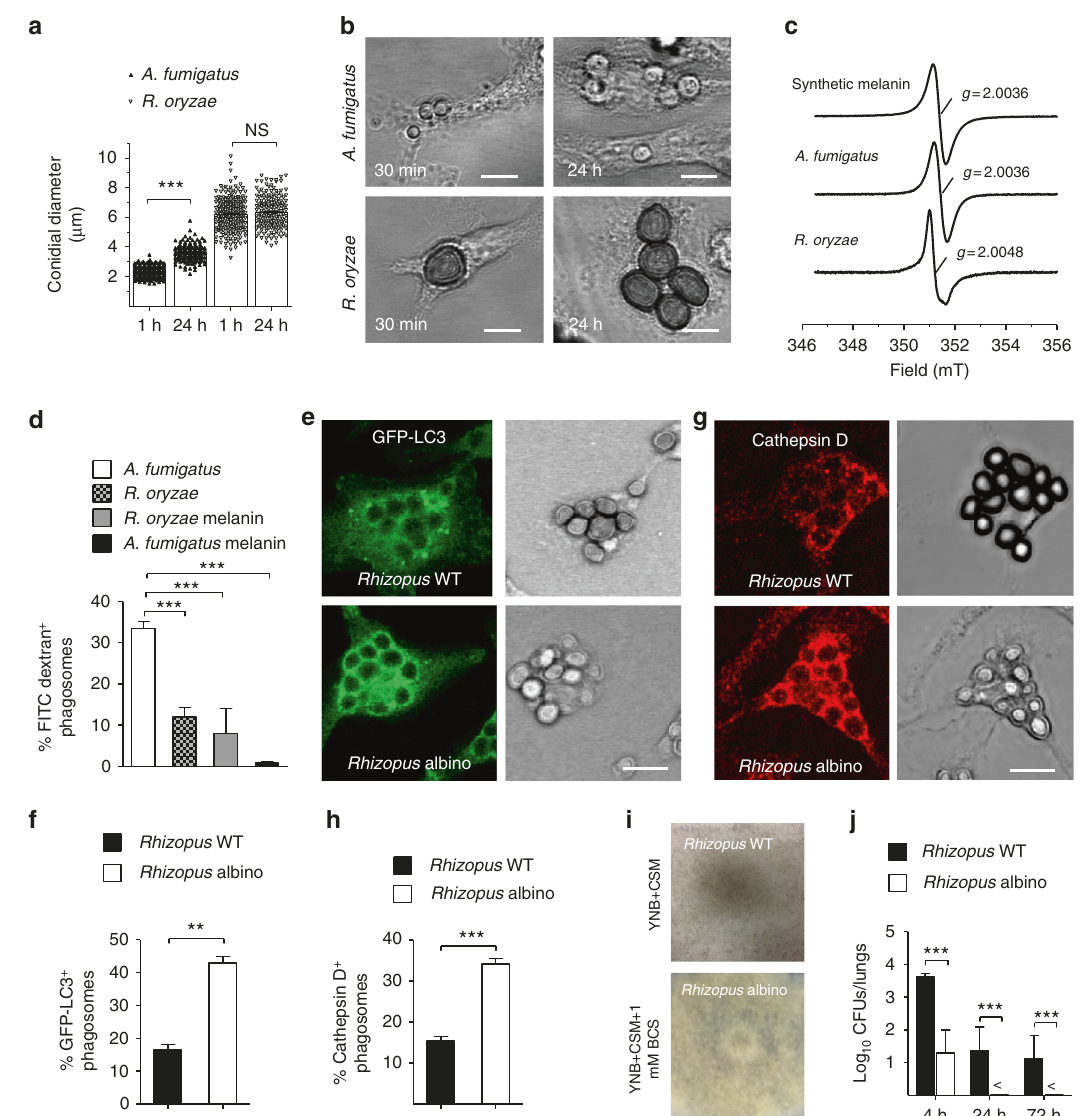
Fig. 5 Rhizopus melanin blocks early event in phagosome biogenesis. a GFP-LC3 BMDMs were infected at 1 or 24 h with live conidia of A. fumigatus or R. oryzae at an MOI 1:1. Cells were fi xed and the conidial diameters of intracellular conidia was measured by confocal microscopy. Data on quanti fi cation of conidial diameter are presented from one out of three independent experiments. Each symbol represents the value of maximum diameter of individual fungal cell and horizontal bars represent the mean diameter. *** P < 0.0001, Mann – Whitney test. b Representative DIC images from a are shown. c X-band room temperature EPR spectra of puri fi ed melanin obtained from A. fumigatus , R. oryzae , or synthetic melanin are shown. d BMDMs pre-loaded with FITC- Dextran were stimulated with conidia of A. fumigatus or R. oryzae or melanin ghosts (puri fi ed melanin particles) obtained from conidia of the indicated A. fumigatus or R. oryzae strains at an MOI of 3:1 (effector:fungal conidia). Cells were removed at 4 h and assessed by confocal imaging. Data on quanti fi cation of FITC-Dextran + phagosomes are presented as mean ± SEM of three independent experiments. e , h BMDMs from GFP-LC3 ( e , f ) or C57BL/ 6 (B6) ( g , h ) mice were infected with R. oryzae conidia (WT conidia) or R. oryzae conidia following chemical degradation of melanin with H 2 O 2 bleaching (albino conidia) at an MOI of 3:1 (effector:fungal cells). Cells were removed at 1 h of infection, fi xed, stained, and analyzed by confocal imaging. Data on quanti fi cation of GFP-LC3 + ( f ) or Cathepsin D + ( h ) phagosomes are presented as mean ± SEM of three independent experiments. e , g Representative fl uorescent images from experiments on f and h are shown. i , j Fungal loads from lungs of immunocompetent mice ( n = 9 per experimental group) infected with 10 6 conidia of R. delemar grown in regular media (WT Rhizopus ) or under conditions of copper starvation to inhibit melanization (albino Rhizopus ) ( i ). Mice ( n = 3 per condition) were sacri fi ced at the indicated time points, lungs were homogenized, and fungal loads were assessed by CFU plating ( j ). *** P <